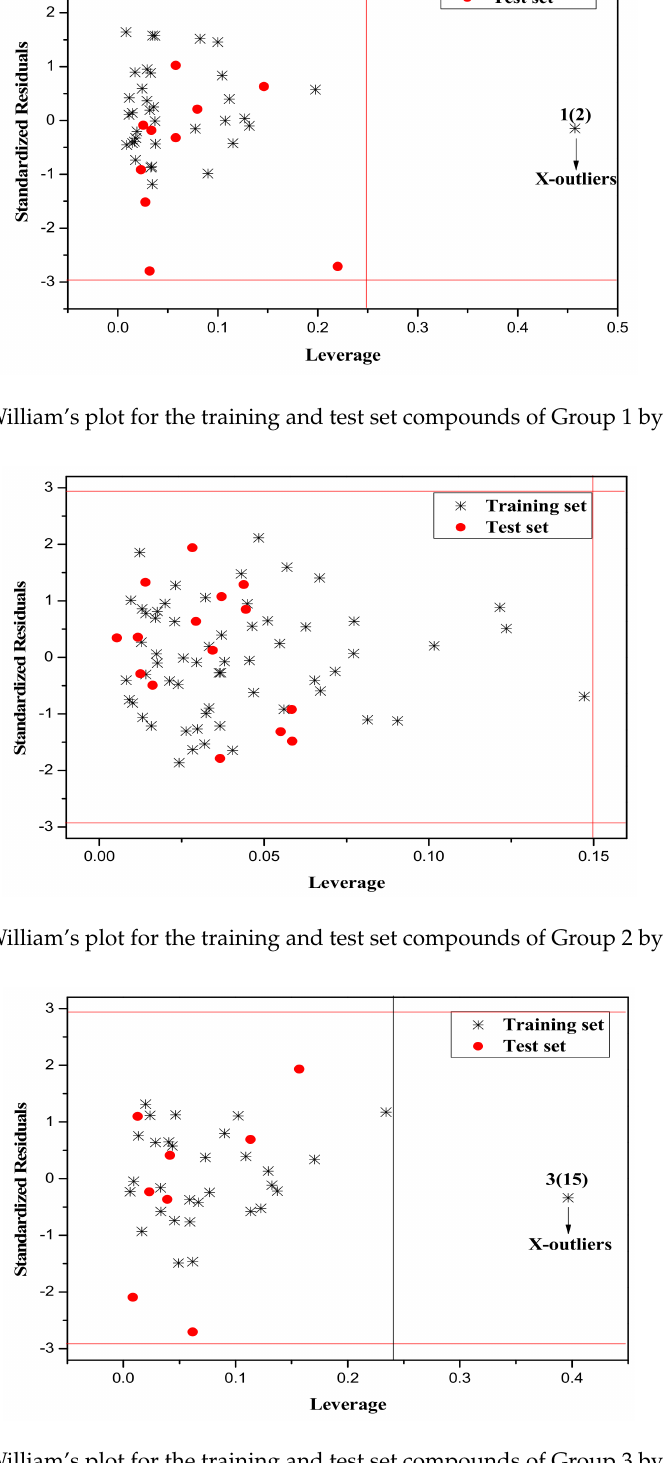
Figure 6. The William’s plot for the training and test set compounds of Group 3 by MLR